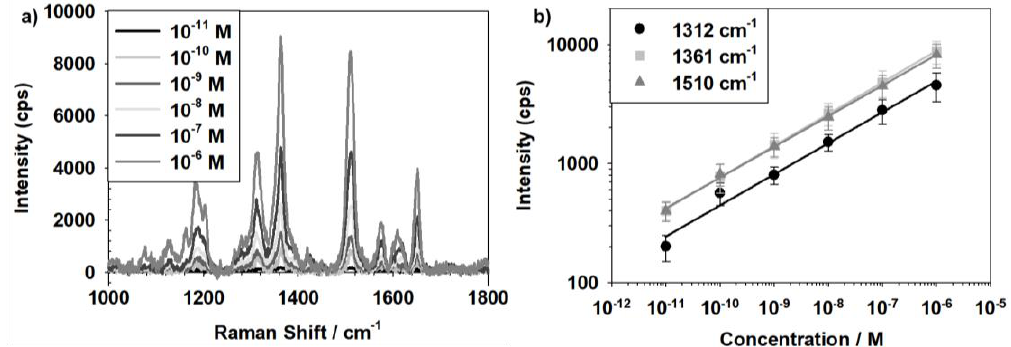
Figure 7. SERS detection limit of SMPs3. ( a ) Raman spectra of SMPs with respect to various concentrations of R6G (10 − 11 M–10 − 6 M). ( b ) Calibration curves of SERS intensity at 1312, 1361, and 1510 cm − 1 in SMPs, matched with peaks in R6G. Five random points in SMPs3 were measured at each concentration ( λ = 633 nm, laser power: 1 mW).